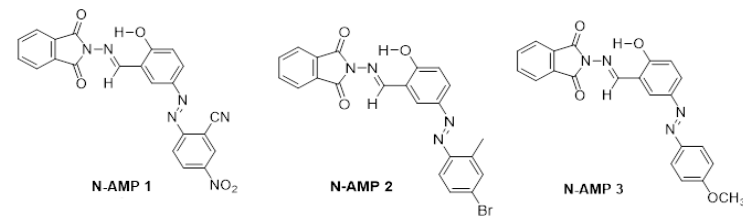
Figure 1. Structure formula of the studied